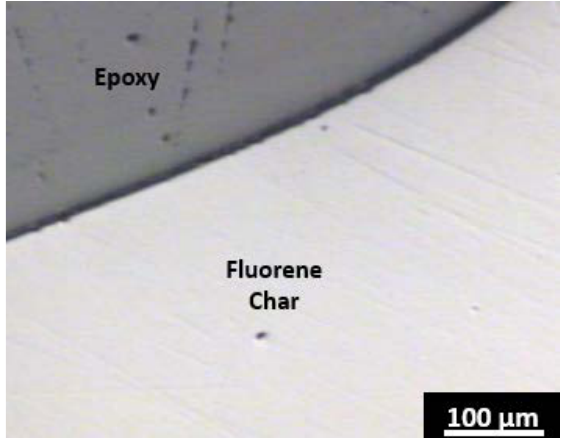
Figure 2. Polarized light micrograph of fluorene char.